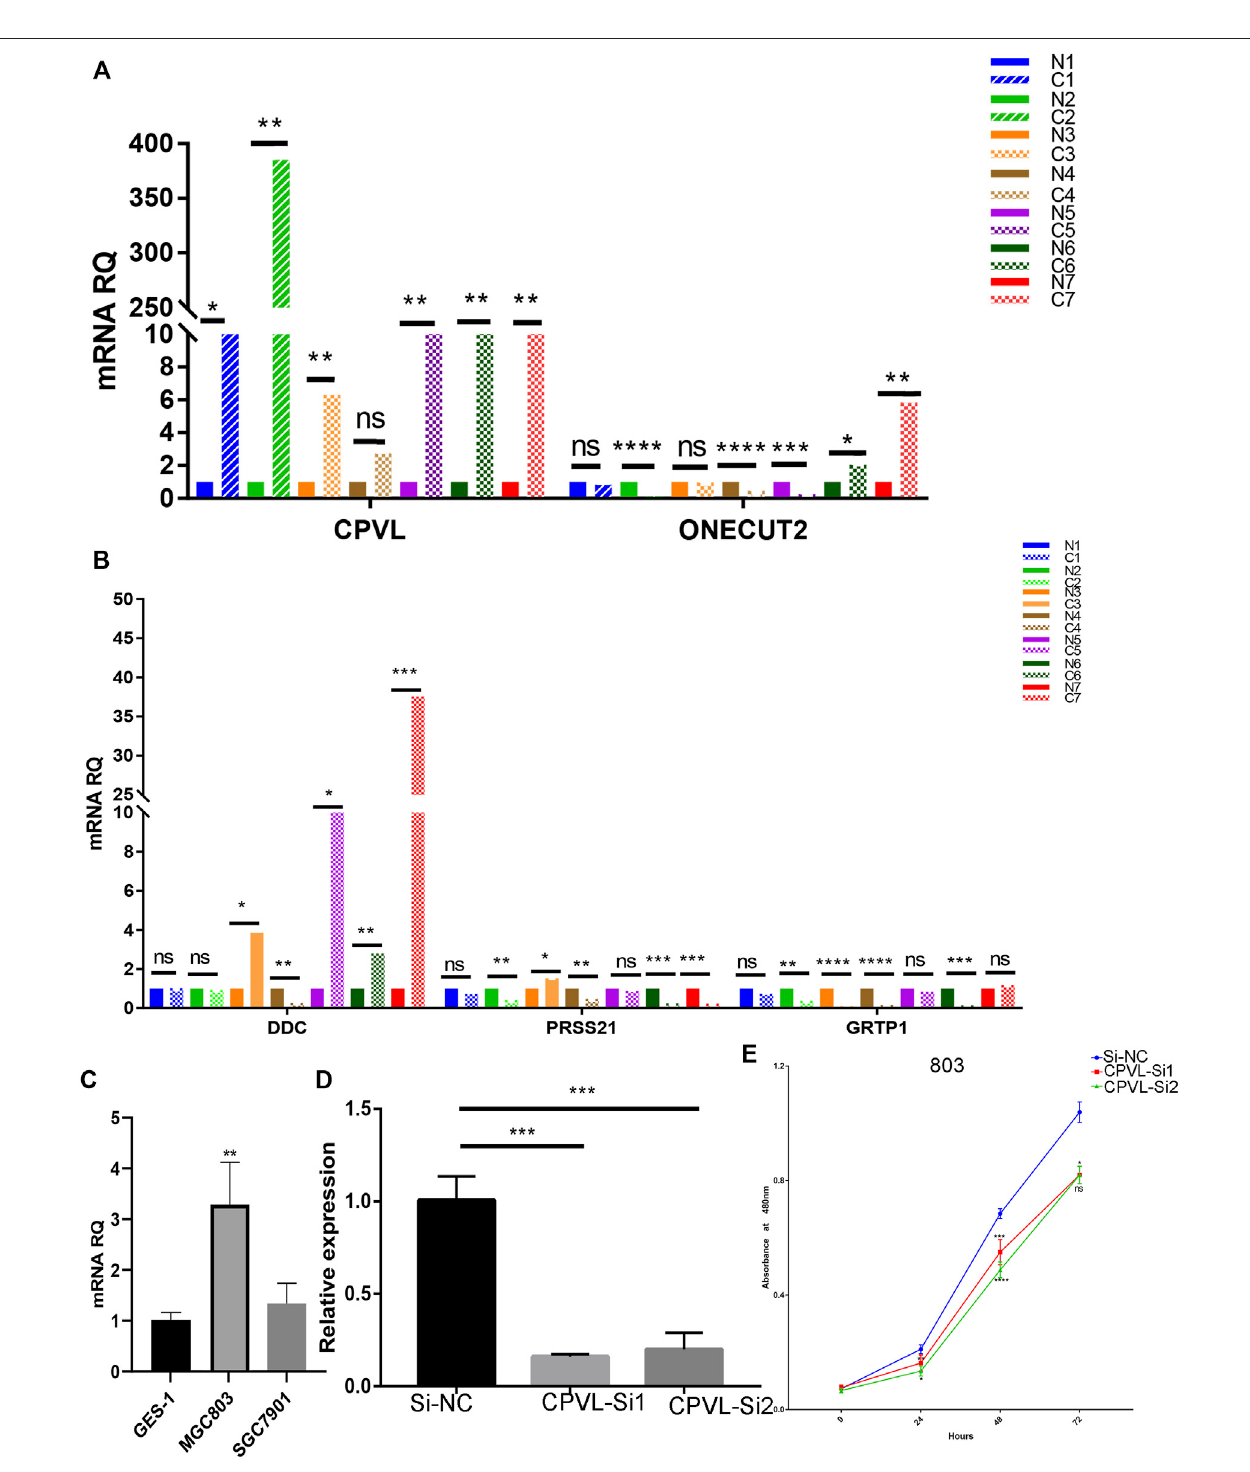
FIGURE7| TheeffectofCPVLoncellularproliferationofGastriccancer. (A,B) Q-PCRanalysisoftherelativeexpressionlevelsof CPVL , ONECUT2 , DDC , PRSS21 , and GRTP1 in gastric cancer and corresponding adjacent tissues. Where “ C ” represents the tumor samples and “ N ” represents the corresponding paracancerous samples. (C) Relative expression of CPVL in gastric cancer cell lines. (D) Knockdown ef fi ciency of CPVL in MGC803. (E) Effects of CPVL knockdown on MGC803 proliferation. (* p < 0.05, ** p < 0.01, *** p < 0.001, **** p < 0.0001).